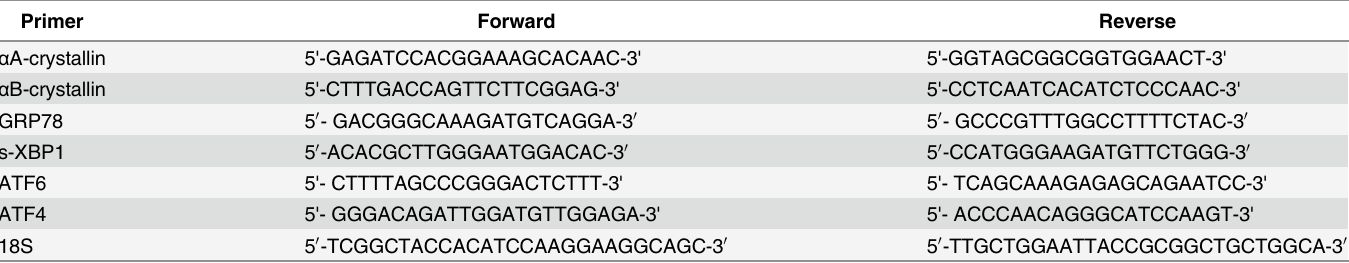
Table 1. Gene-specific primers sequences for real-time PCR.